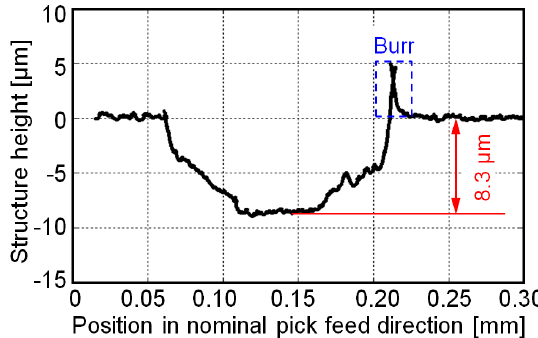
Figure 6. Machined micro structures on aluminum alloy by applying textured cutting tool.